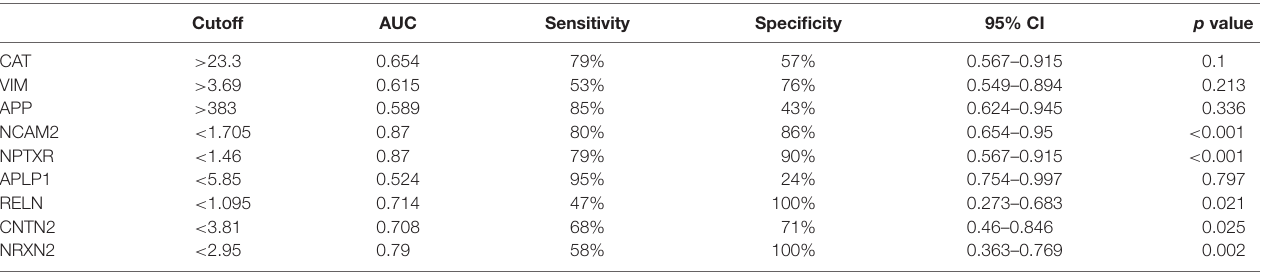
TABLE 3 | Sensitivity, specificity, cutoff value, and AUC for each candidate biomarker.